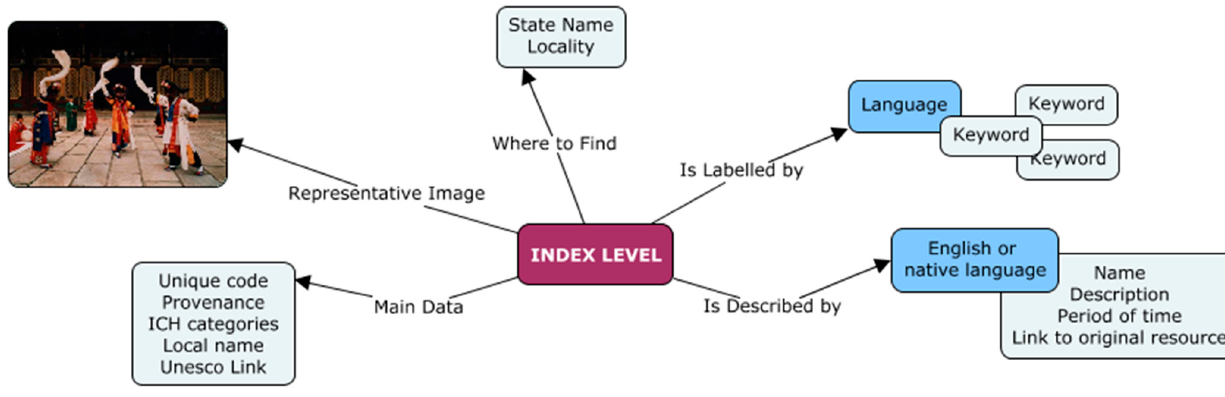
Figure 2. Index level.